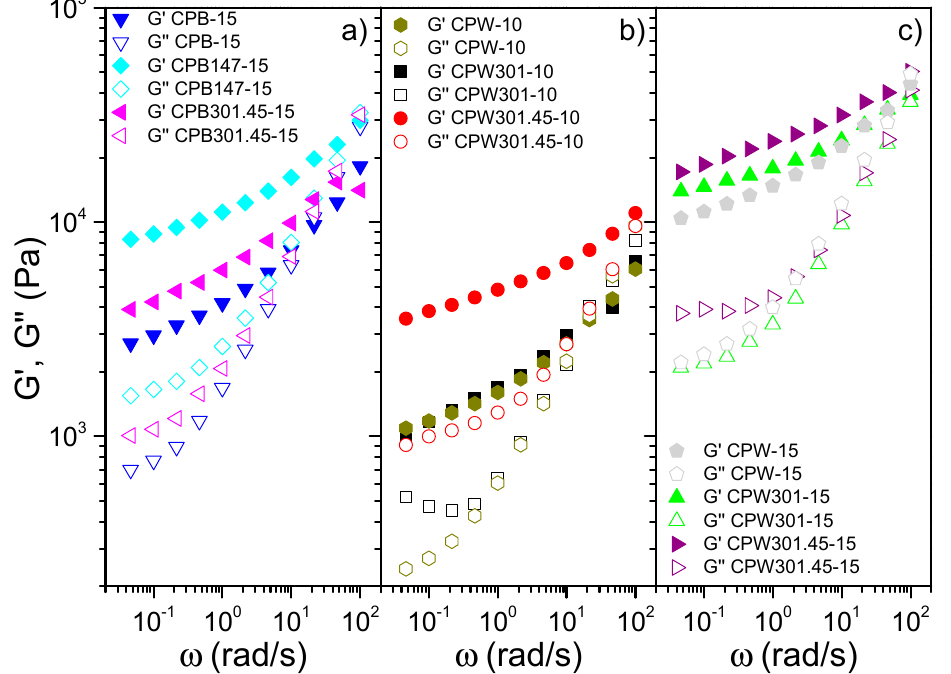
Figure 4. Evolution of the storage and loss moduli with frequency for oleogels containing ( a ) 15% barley-straw-derived cellulose-pulp-based thickener, ( b ) 10% wheat-straw-derived cellulose-pulp-based thickener, and ( c ) 15% wheat-straw-derived cellulose-pulp-based thickener.